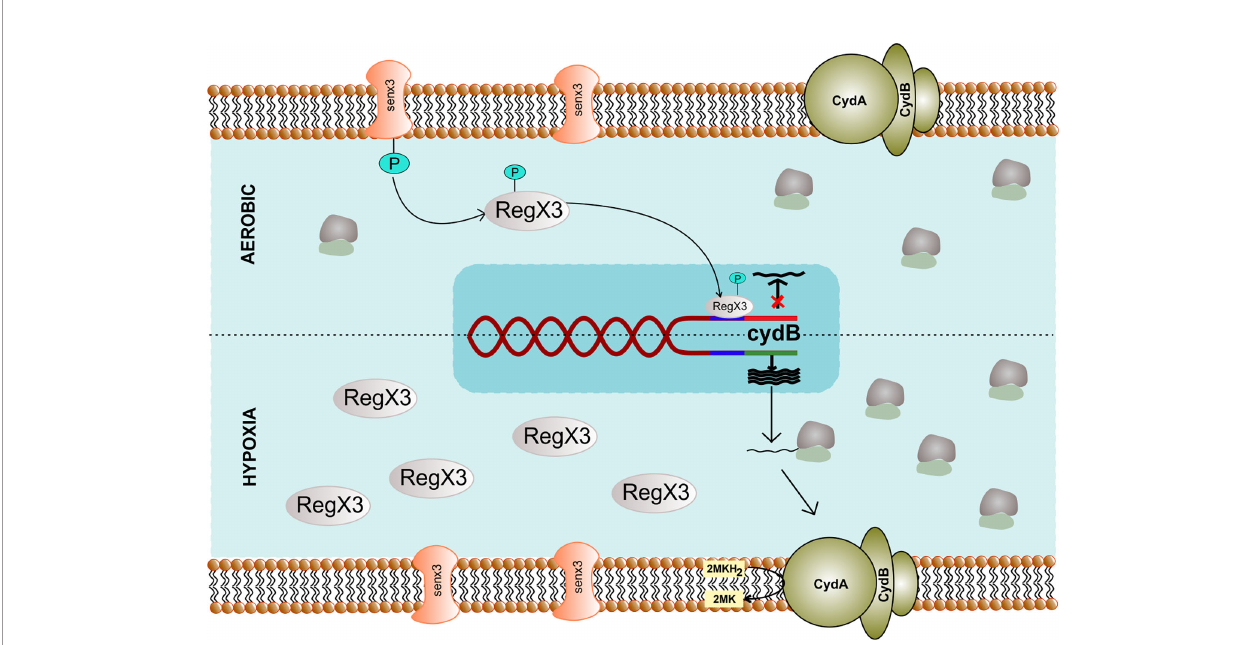
FIGURE 3 | Genetic regulation of cytochrome bd complex. The expression of cydB component of terminal oxidase cytochrome bd depends upon SenX 3 – RegX 3 two-component system speci fi c to Mycobacterium. During the aerobic condition, phosphorylated RegX 3 binds to the promoter region of cydB and inhibits transcription. However, during hypoxia, RegX 3 gets dephosphorylated and does not bind to the promoter of cydB, thus facilitating its expression.